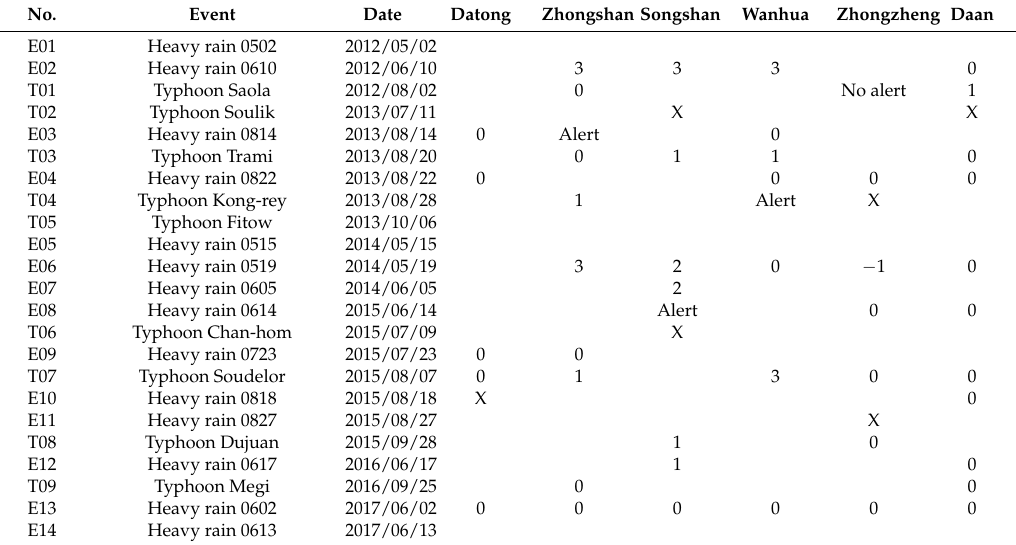
Table 12. The improvements in early warning time in the adjusted vs. original